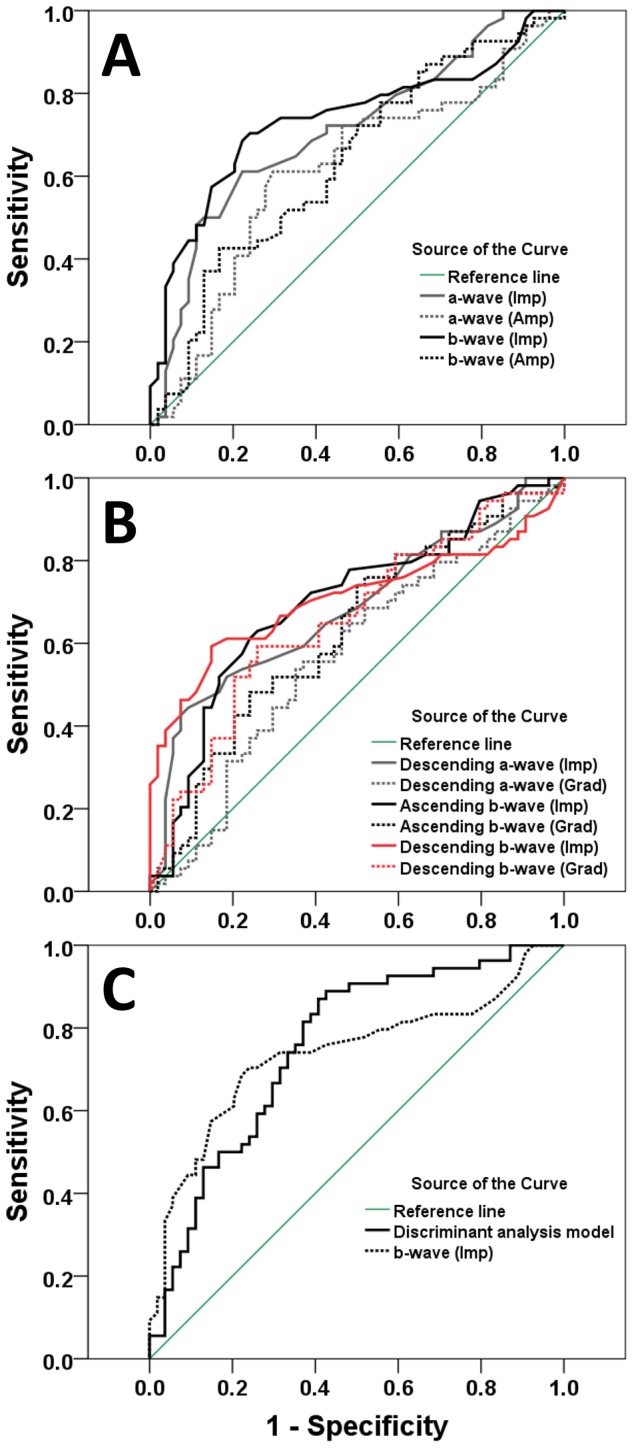
Receiver operating characteristic curves for study parameters.(A) Conventional parameters, (B) 1st & 2nd derivative parameters, (C) Discriminant analysis (Key used to denote individual parameters). Each plot shows the sensitivity of the parameter to early AMD against the false detection rate (1 - specificity) for all study participants (n = 108), a greater area under the curve (AUC) indicates better discriminatory ability. Abbreviations - Imp  =  implicit time; Amp  =  amplitude; Grad  =  gradient